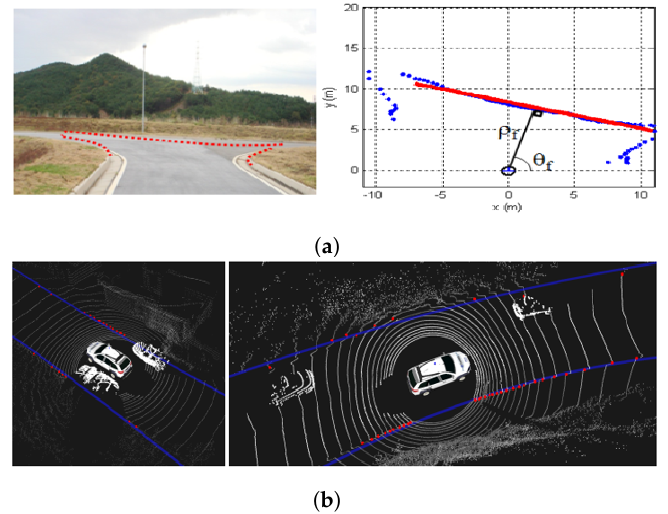
Figure 7. Road curb using LiDAR sensors: ( a ) LiDAR 2D [27]. ( b ) LiDAR 3D